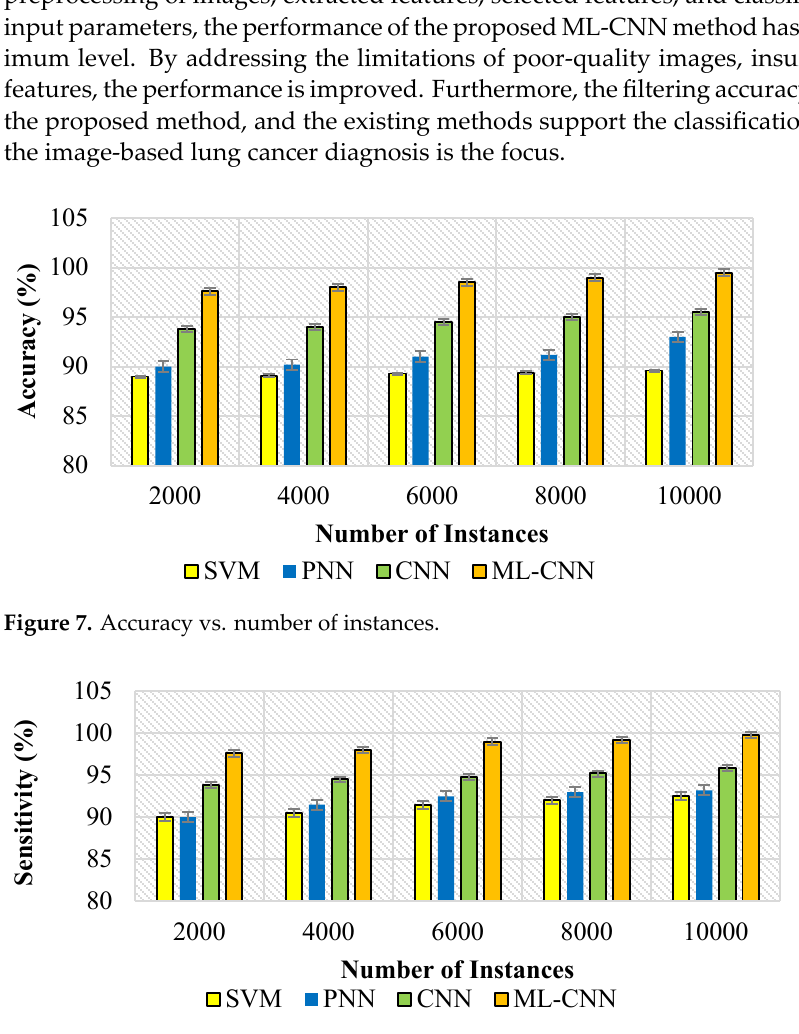
Figure 9. Specificity vs. number of instances . Figure 10. Precision vs. number of instances . Figure 11. F-score vs. number of instances .